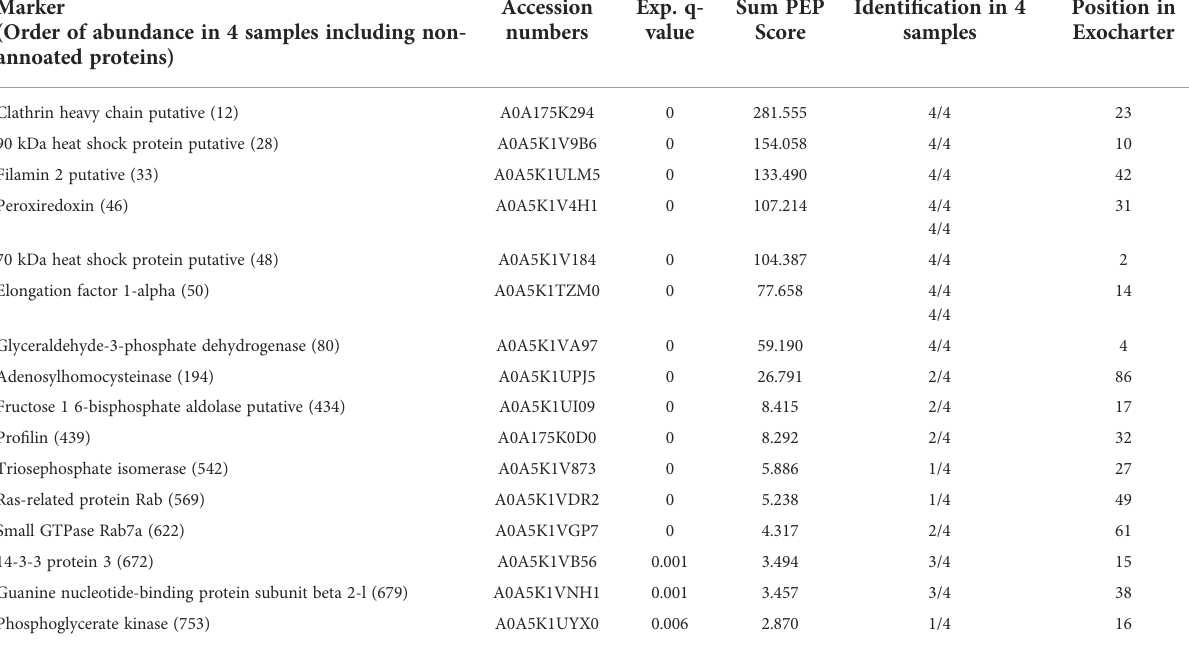
TABLE 1 Typical exosomal markers found in EVs from E. histolytica trophozoites. Marker (Order of abundance in 4 samples including non-